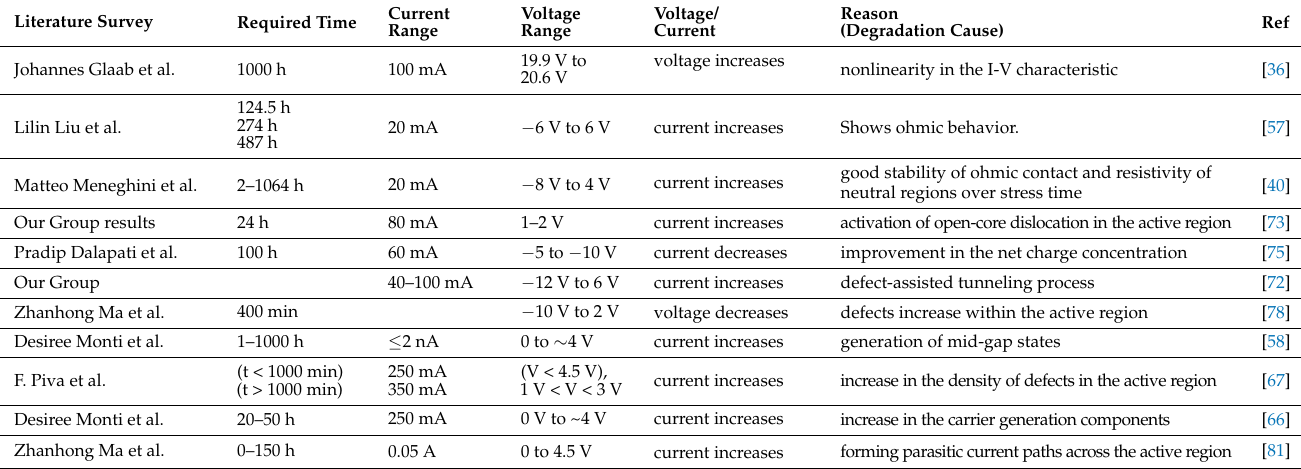
Table 4. A summary of the I-V response to the stress.